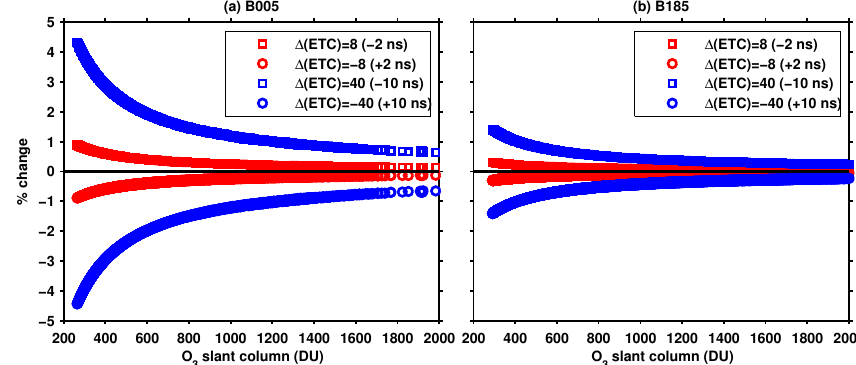
Figure 6. Changes (%) in the calculated TOC due to changes in the ETC resulting from ± 2 and ± 10ns change in DT, as a function of the slant column of ozone for B005 (a) and B185 (b) . For B005 the used ETC has been changed by ± 8 units for a ± 2ns change of the DT and by ± 40 units for a ± 10ns change of the DT. For B185, the corresponding changes of the ETC are ± 3 and ± 15